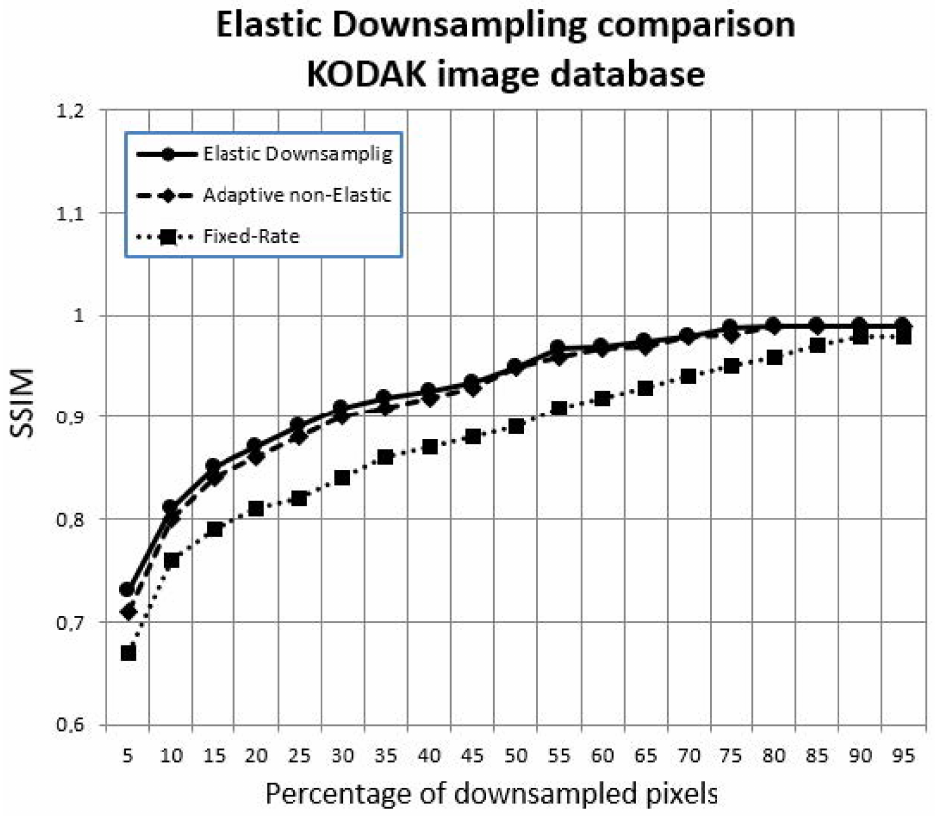
Figure 12. SSIM metric comparison. A visual comparison between conventional (fixed-rate), adaptive nonelastic, and elastic downsampling is shown in Figure 13. It clearly shows that the boat and sail details, especially the numbers, are better protected with the elastic